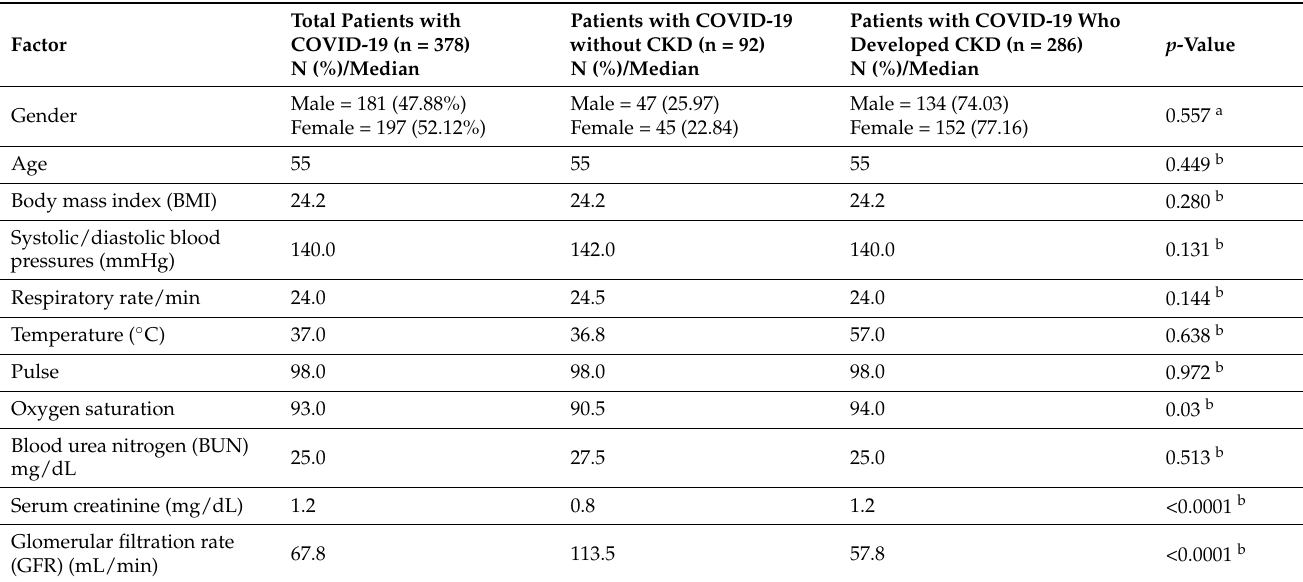
Table 1. Association between CKD and the sociodemographic, vital signs, and kidney function parameters during hospital admission.